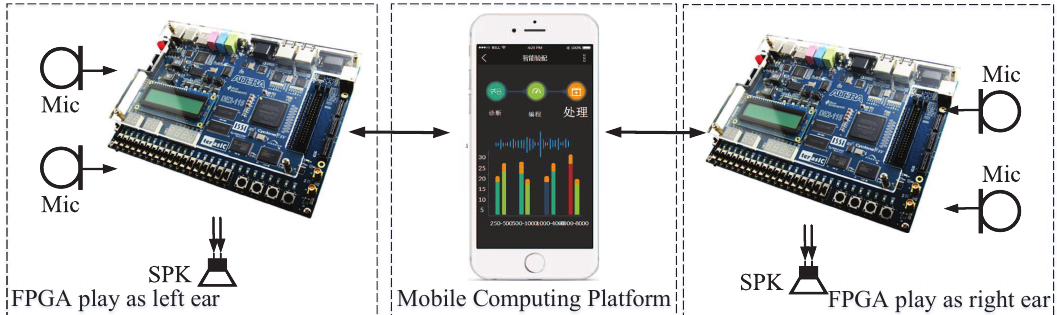
Figure 14. Overview of the verification system.